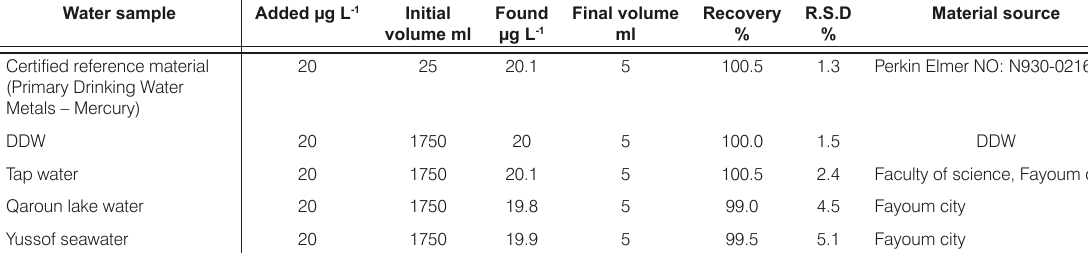
Table 2. Determination of Hg (II) from different real water samples average of 6 detection.